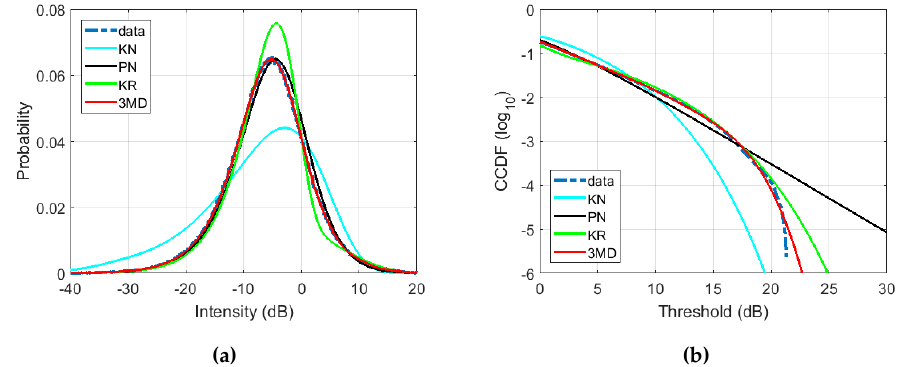
Figure 7. Amplitude distributions for the NetRAD data (Run 4): S-band, HH-polarization, bistatic acquisition, bistatic angle 60°. Illustrations show the ( a ) PDF, ( b ) CCDF. Table 4. Parameter estimates for the models in Figure 7.